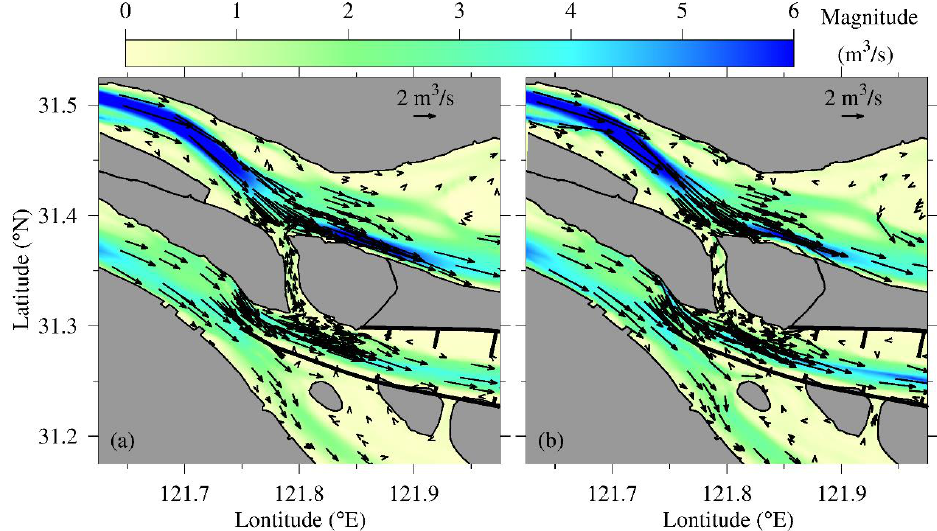
Figure 10. Residual water transports during the neap tide ( a ) and spring tide ( b ) in EX0.